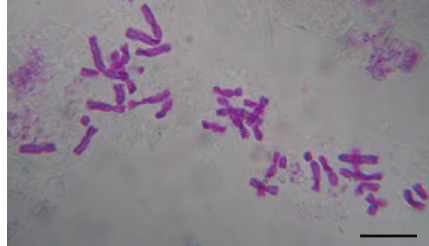
Figure 7. Ornithogalum etruscum Parl. subsp. etruscum , 2 n = 36. Scale bar: 10